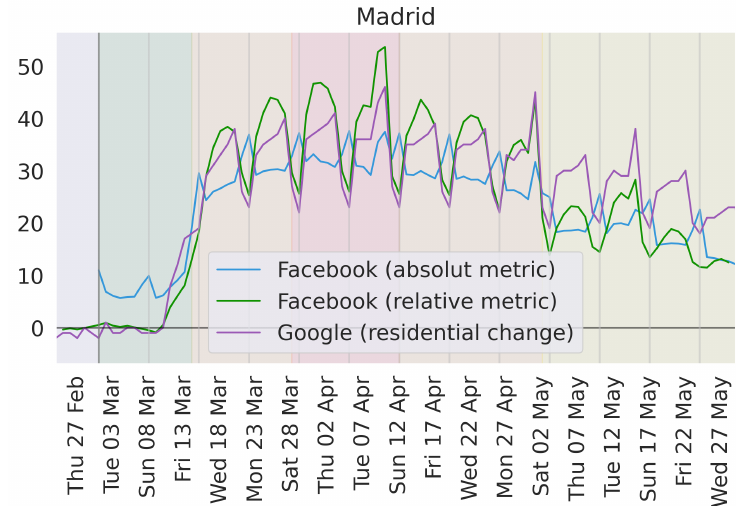
Figure 4. Evolution of mobility according to Facebook absolute change (blue), Facebook relative change (green) and Google (purple). Facebook relative change has been divided by 100 to match the scale of the other two indices. Vertical bands (green, orange, red, orange, green) correspond to pre- confinement, state of alarm declaration and lockdown, hard lockdown, lockdown and de-confinement stages. Grey vertical lines are aligned with every Sunday.